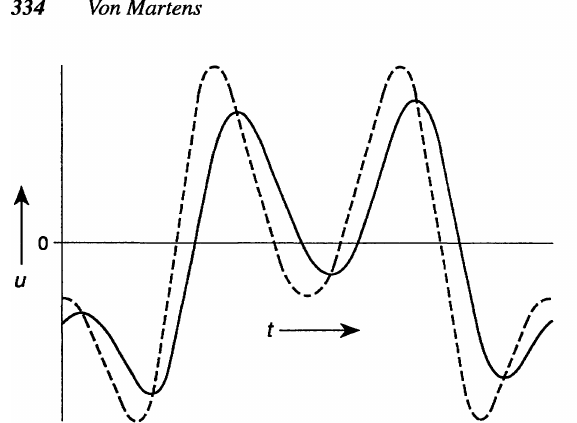
FIGURE 4 Demonstration of distortion influence of fil tering on the interferometer signal u(t). Sinusoidal motion x = quantity with deflection amplitude fl.x/2, interferome ter signal zero phase angle <Po = 2rr/5. Broken: unfiltered interferometer signal; solid: interferometer signal filtered by low-pass of 1st order.